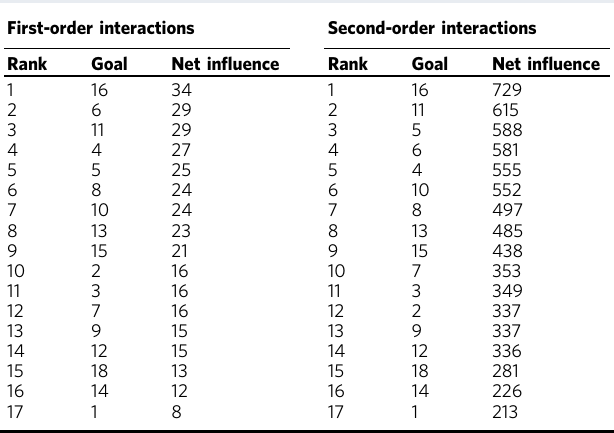
Table 2 Rank of goals in fl uencing the network based on fi rst and second-order interactions.